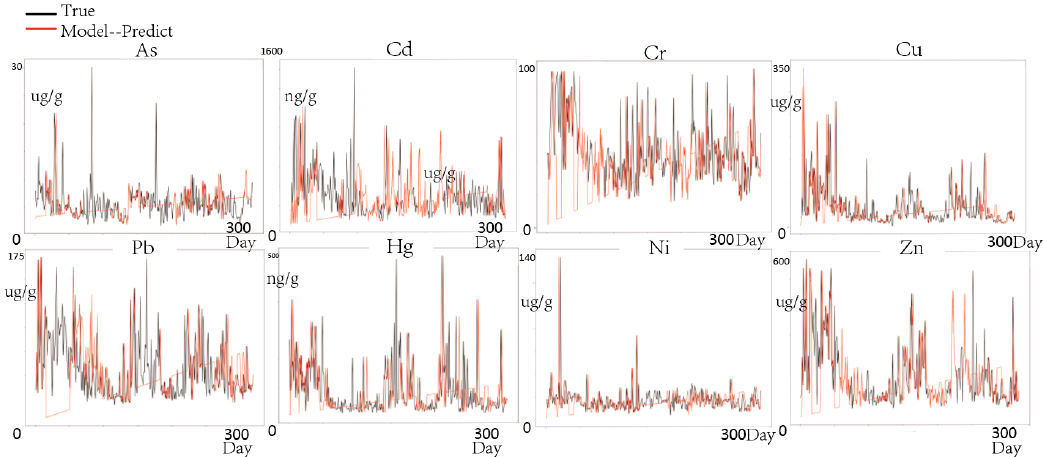
Figure 10. The effect of the improved model. Figure 10. The e ff ect of the improved